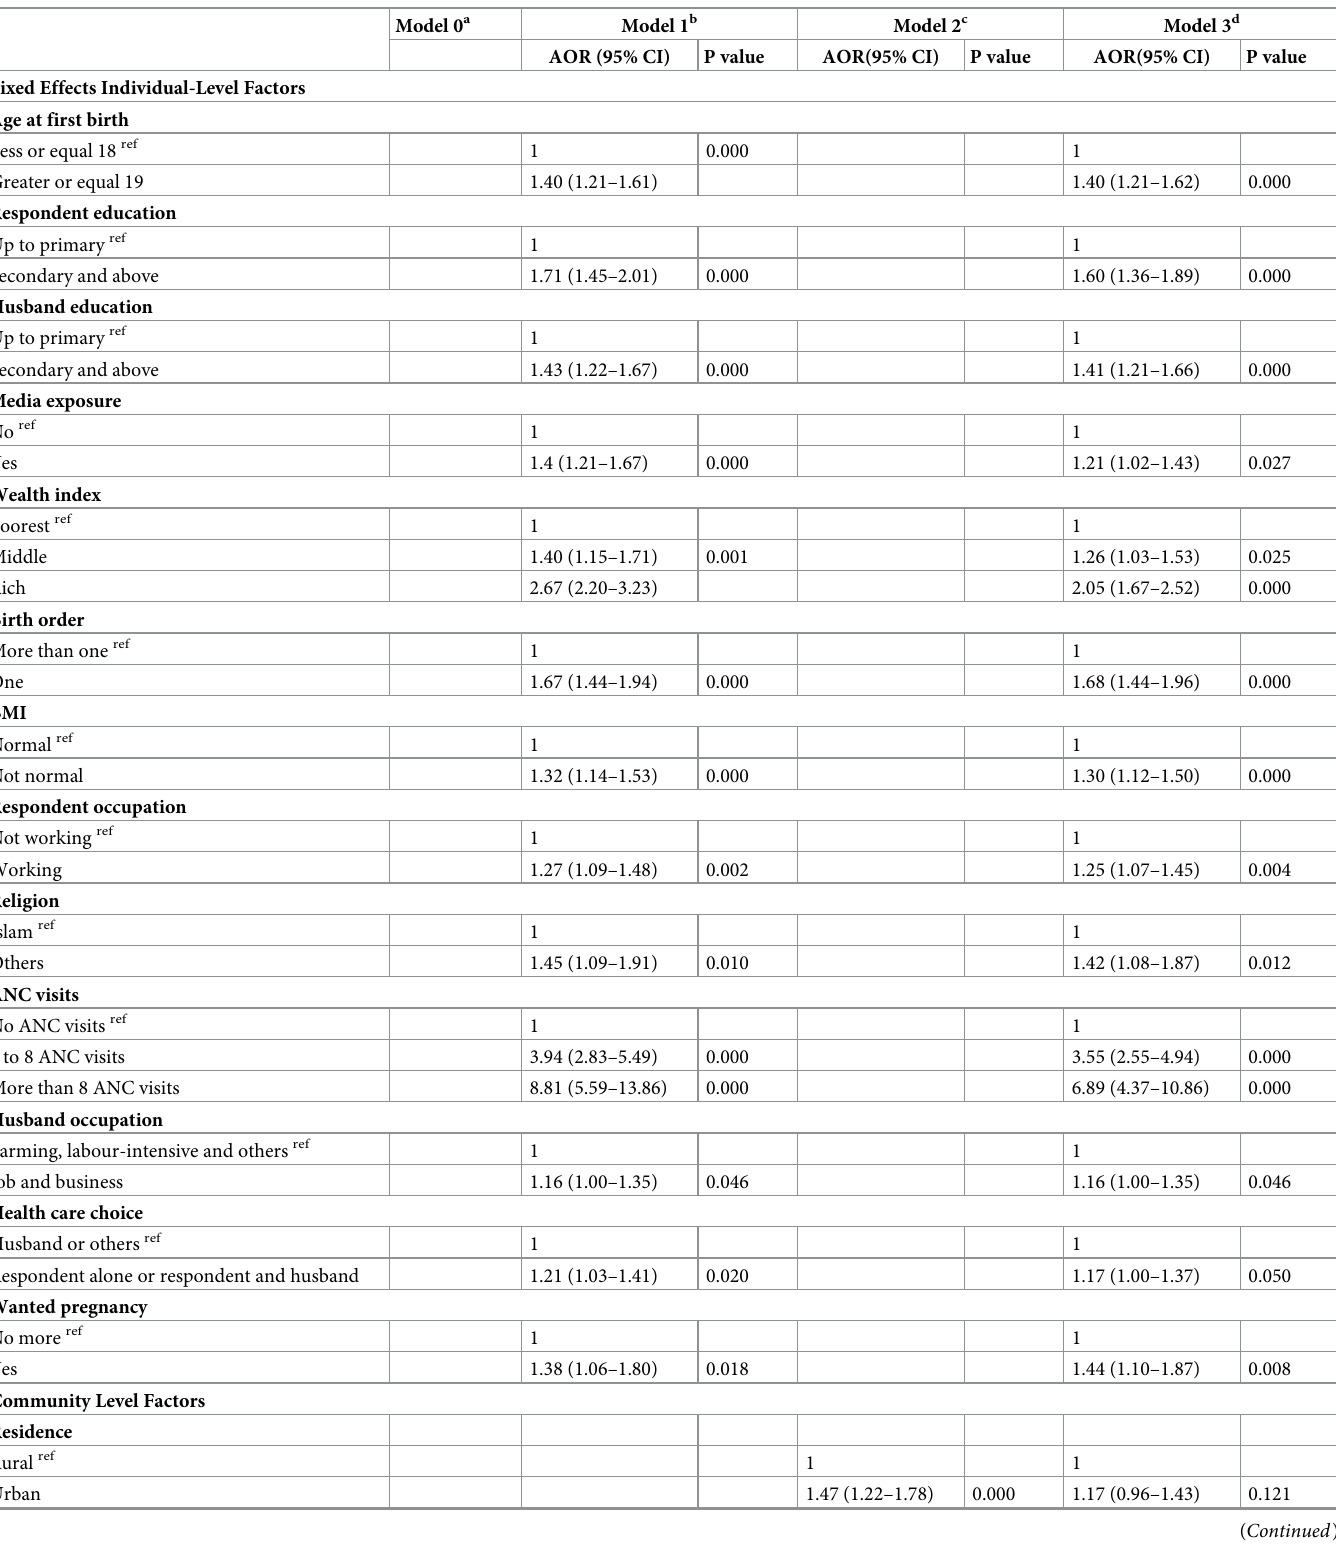
Table 4. Multilevel binary logistic regression analysis of individual- and community-level factors in SBA use among women in Bangladesh, 2017–2018